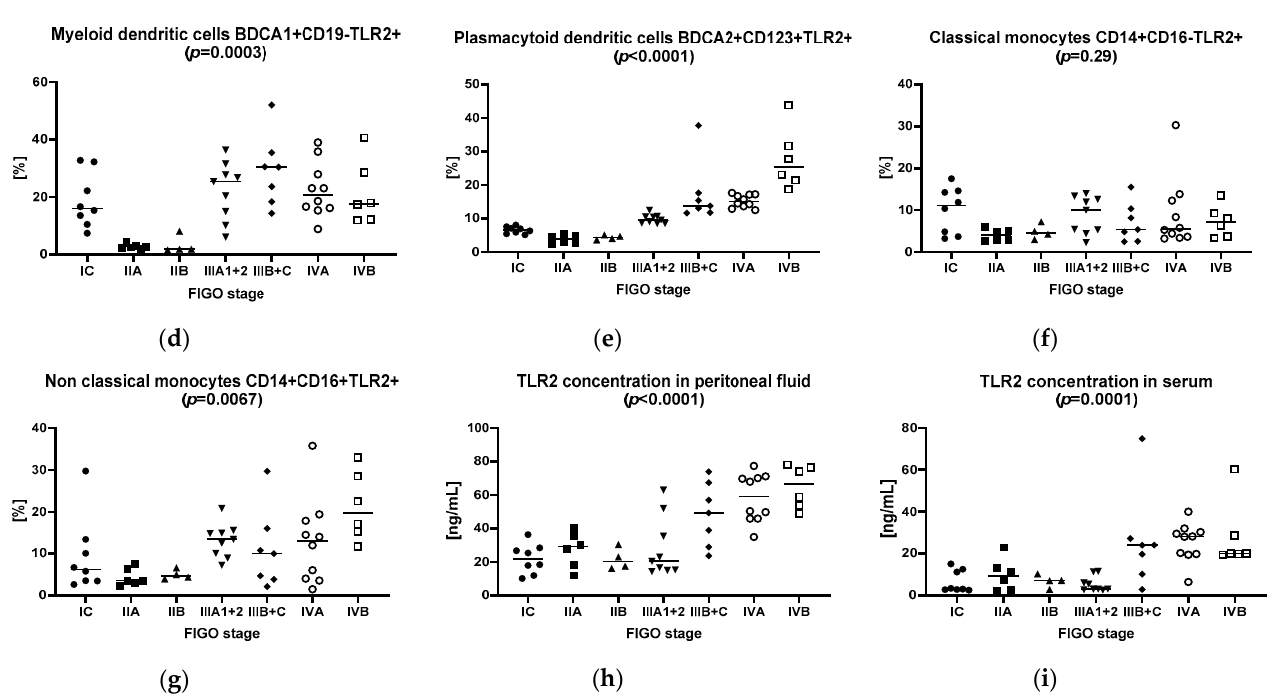
Figure 1. The frequencies of the dendritic cell, monocyte and basic peripheral blood lymphocyte subsets expressing the TLR2 antigen of ovarian cancer patients with different FIGO stages. ( a ) T lymphocytes CD4+ TLR2+; ( b ) T lymphocytes CD8+ TLR2+; ( c ) B lymphocytes CD19+ TLR2+; ( d ) myeloid dendritic cells BDCA1+ CD19 − TLR2+; ( e ) plasmacytoid dendritic cells BDCA2+ CD123+ TLR2+; ( f ) classical monocytes CD14+ CD16 − TLR2+; ( g ) non-classical monocytes CD14+ CD16+ TLR2+; ( h ) TLR2 concentration in peritoneal fluid; ( i ) TLR2 concentration in serum.